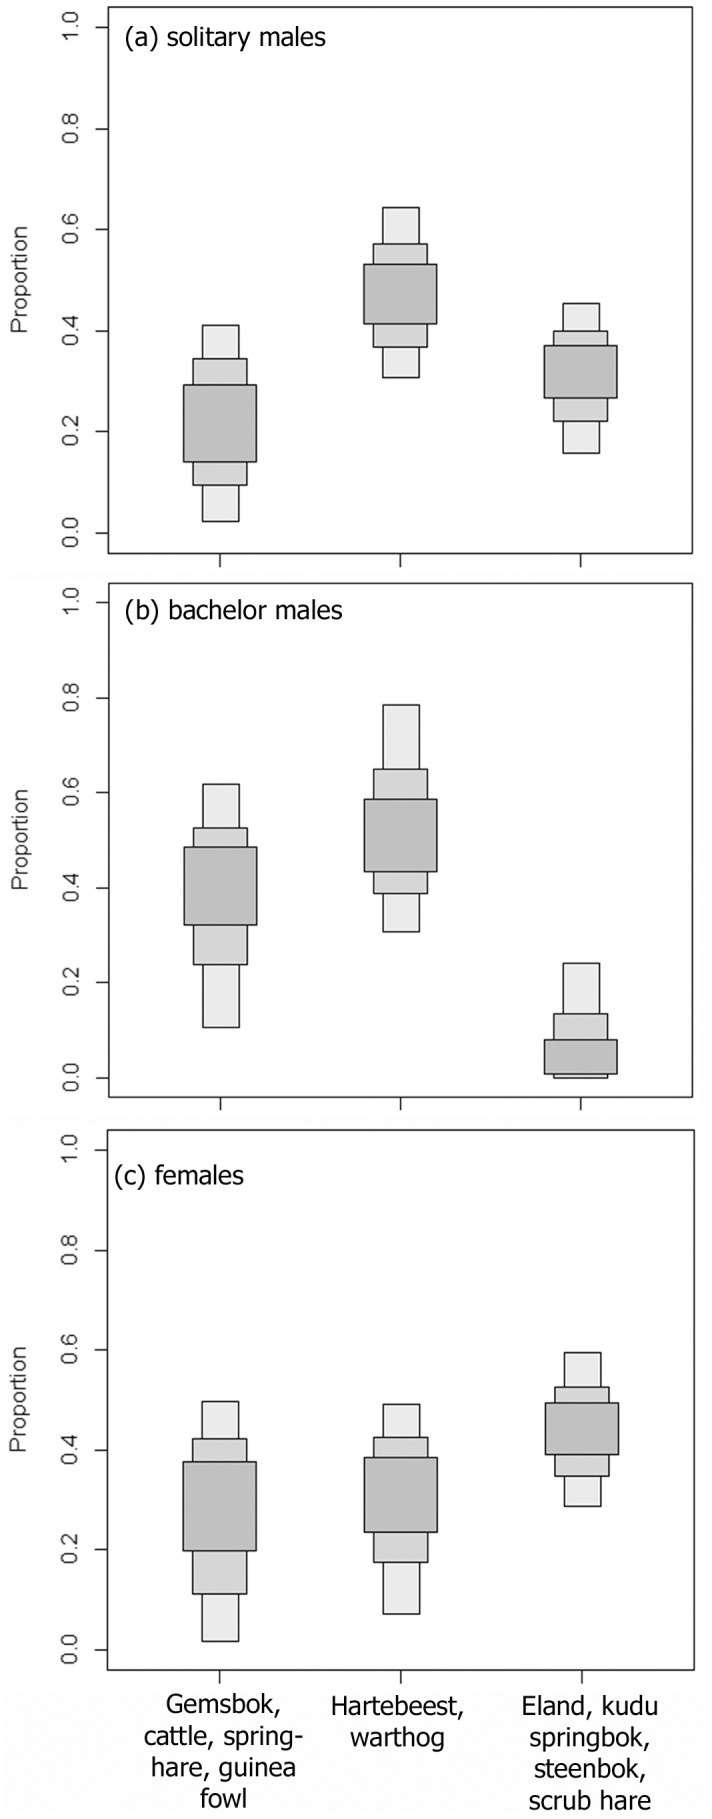
Relative proportions of isotopically distinct categories of potential prey to the diet of solitary male cheetahs (a), male cheetahs foraging in a bachelor group (b) and female cheetahs (c) as determined by a Bayesian isotopic mixing model.Box plots show the relative proportions for each food source with 95% (dark grey), 75%, 25% (medium grey) and 5% (light grey) confidence intervals.